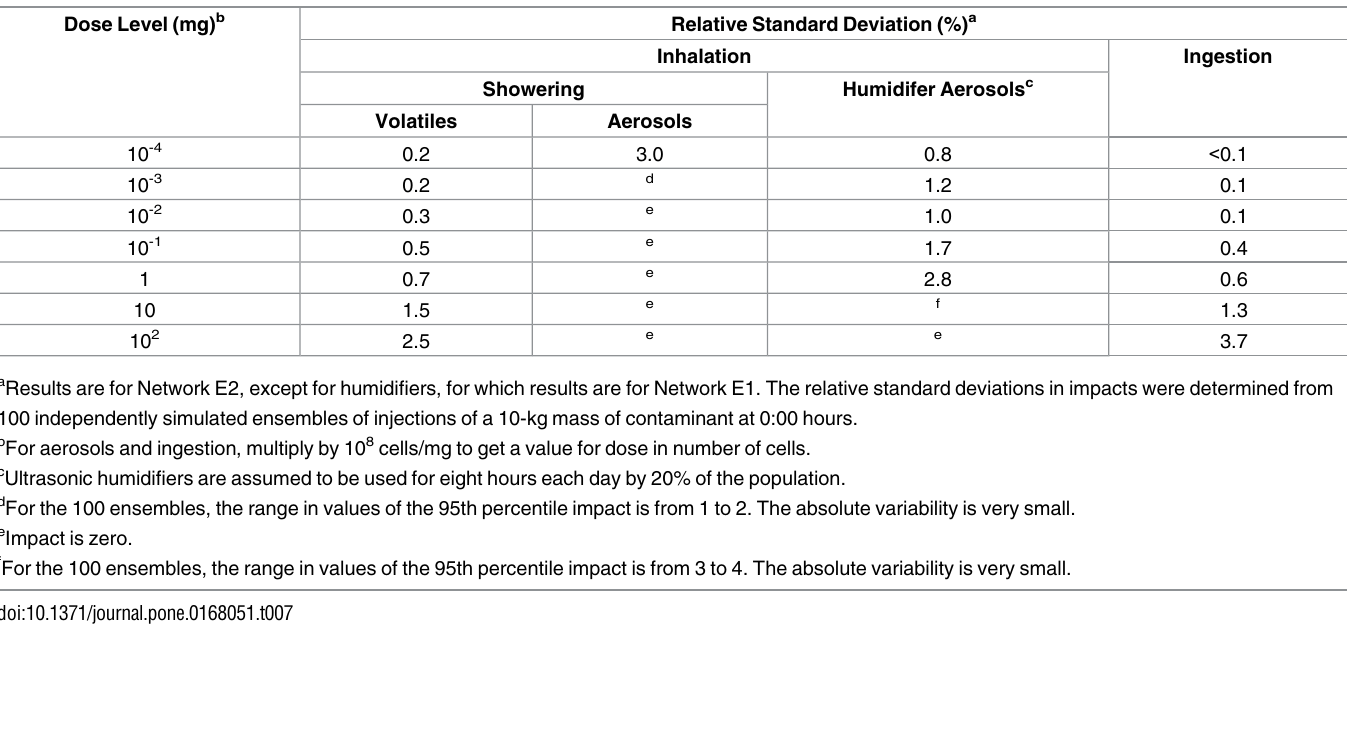
Table 7. Variability in 95th Percentile Impacts Due to the Probabilistic Nature of Behavior